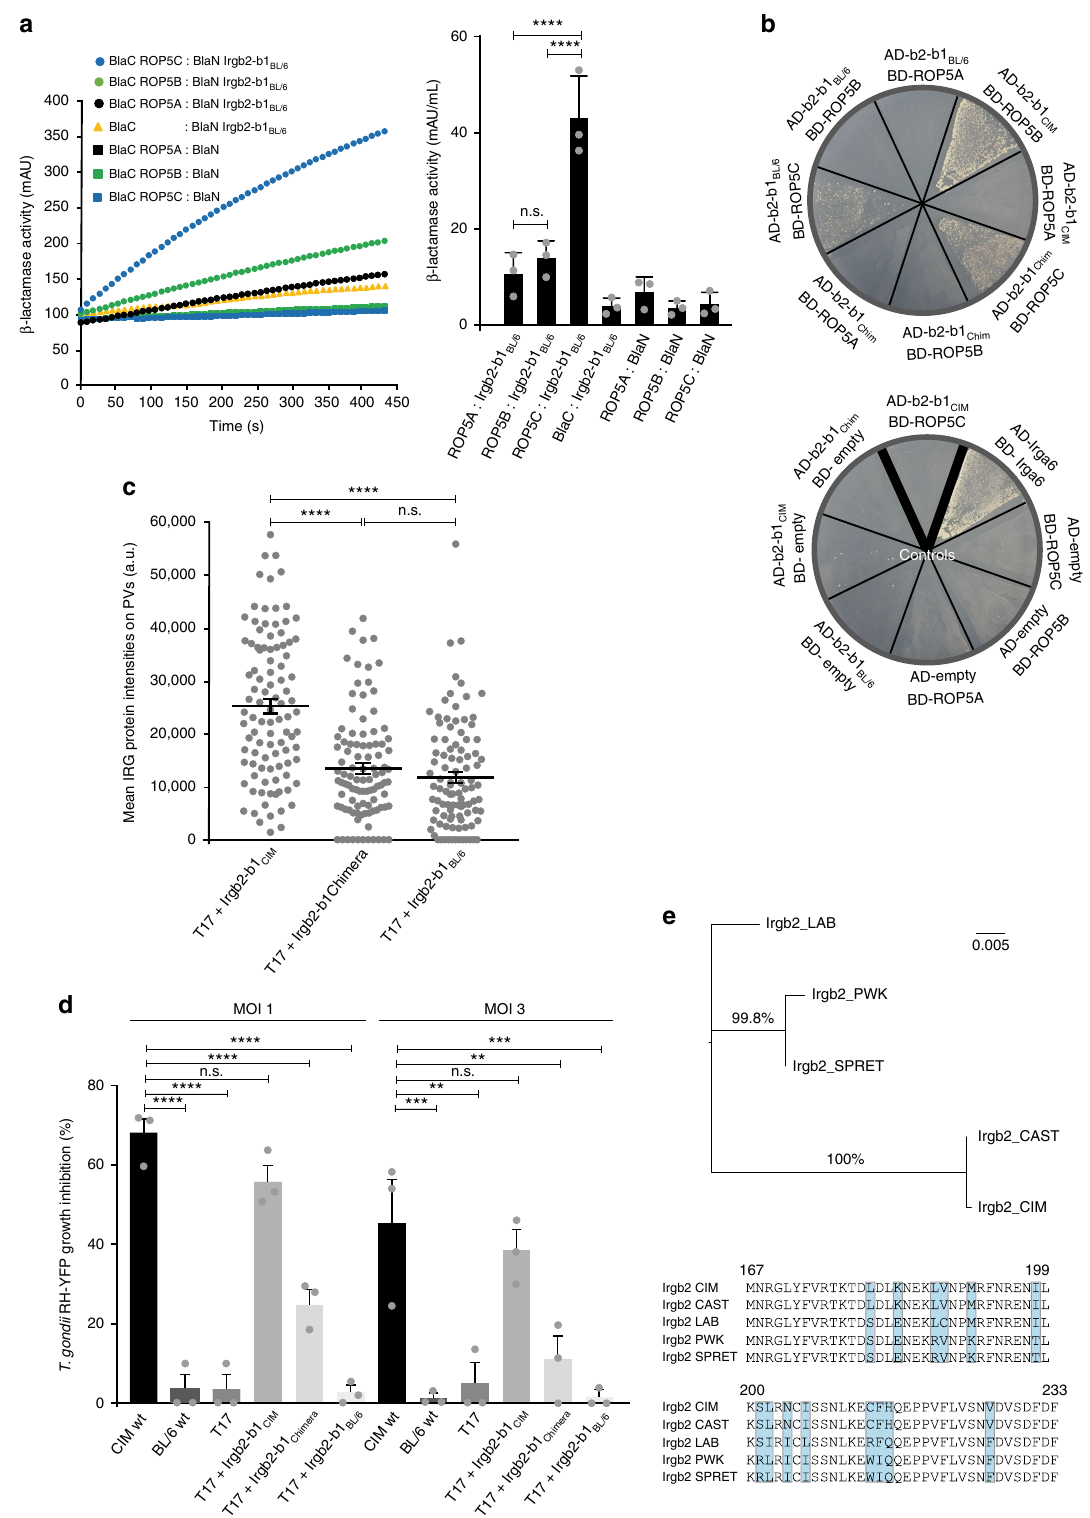
b1 CIM could be detected, whereas no interaction with Irgb2-b1 CIM for any of the VAND ROP5 isoforms was visible in our assays (Fig. 6). In summary, in VAND infections, escape from Irgb2- b1 CIM binding conclusively results in increased Irga6 CIM phos- phorylation and is therefore a very likely explanation for viru- lence of T. gondii VAND in CIM cells and mice (Fig.